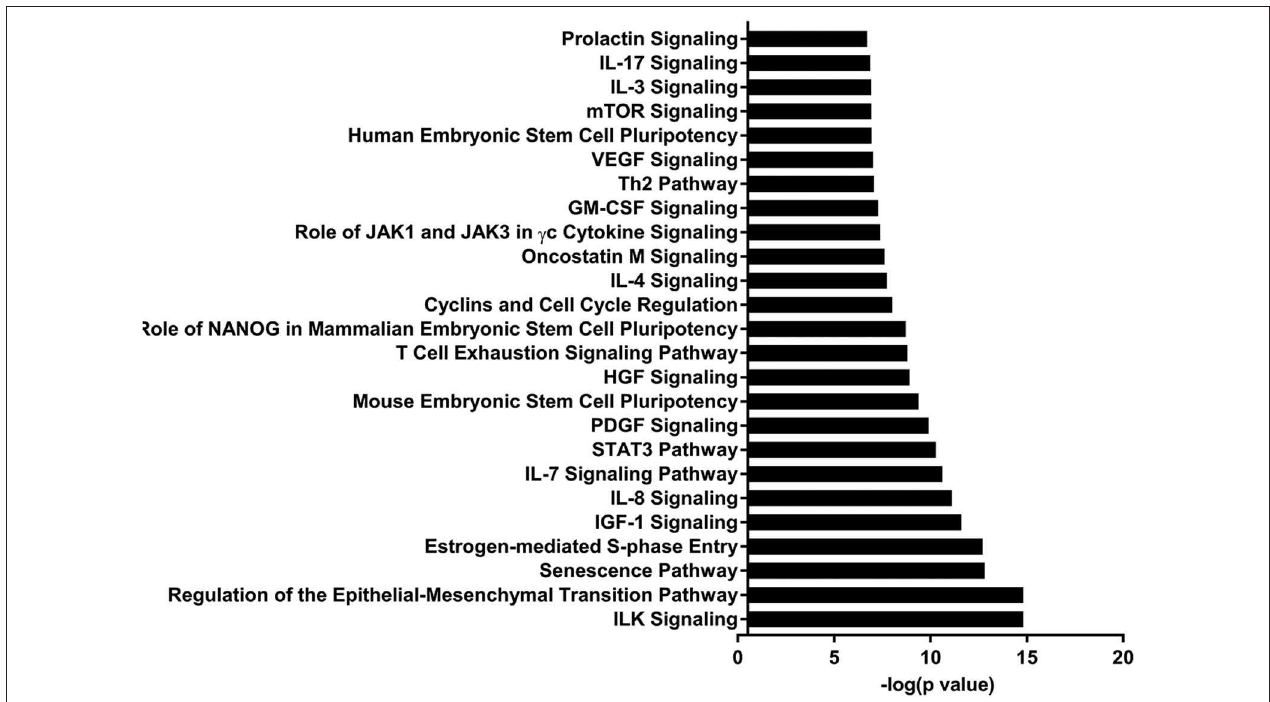
FIGURE 3 | Enriched pathways of MF compared to HM at PND35. IPA of target predicted genes for downregulated miRNA in MF relative to HM at PND35. The data represents from 4 MF and 4 HM fed